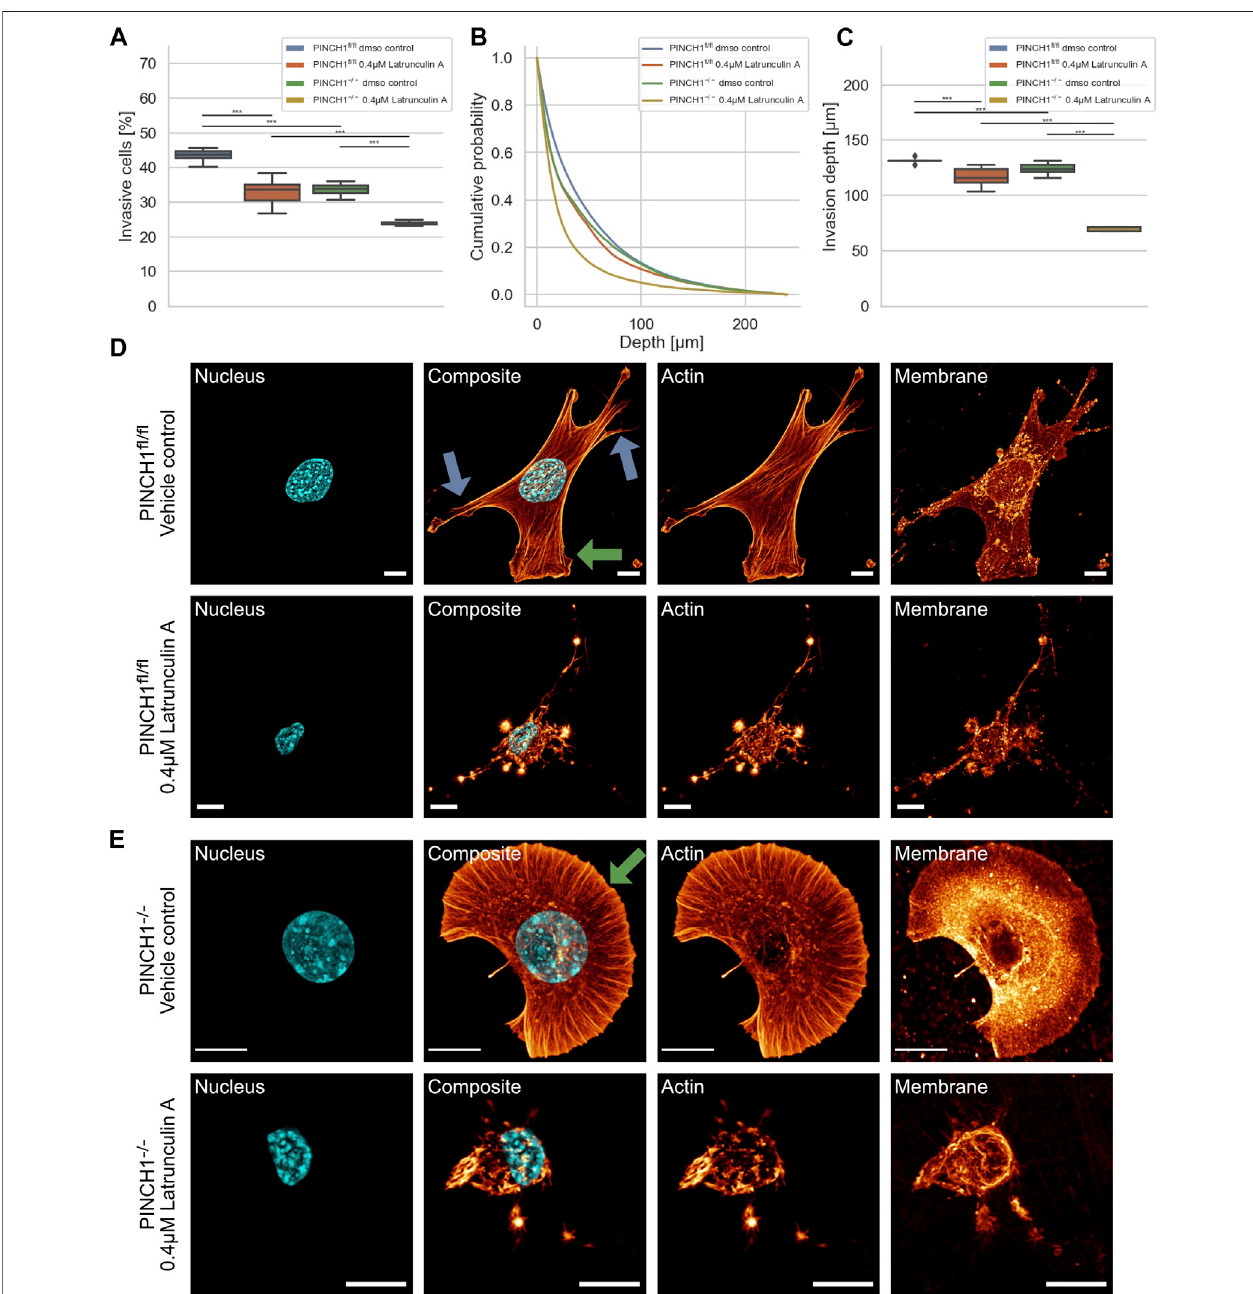
FIGURE 3 | 3D collagen invasion of PINCH1 − / − and PINCH1 fl / fl cells in the presence or absence of Latrunculin A treatment. (A) Average percentage of invasive migrating PINCH1 − / − cells (yellow, n = 982,978 cells with Latrunculin A; green, n = 312,813 buffer-treated control cells) is pronouncedly decreased compared to PINCH1 fl / fl cells (red, n = 307,743 cells with Latrunculin A; blue, n = 1,135,294 buffer-treated control cells) after Latrunculin A. The Latrunculin A-treatment caused a reduction in the percentage of invasive cells compared to their buffer-treated controls. (B) Invasion depth pro fi les of the invasive PINCH1 − / − cells (green, n = 105,835 cells in the absence, yellow, n = 236,225 in presence of Latrunculin A and invasive PINCH1 fl / fl cells (blue, n = 495,742 cells in the absence, red, n = 101,896 in presence of Latrunculin A that migrated in the 3D extracellular matrices after three days of culture at 37 ° C, 95% humidity and 5% CO 2 in the presence and absence of Latrunculin A. (C) The invasion depths of Latrunculin A-treated PINCH1 − / − cells is most pronouncedly impaired compared to Latrunculin A-treated PINCH1 fl / fl cells. Moreover, the average invasion depths of PINCH1 − / − cells (green column) is pronouncedly lower compared to PINCH1 fl / fl cells (blue column) either in the presence or absence of Latrunculin A. (A,C) data are presented as box and whiskers plots (Q2 represent mean values). (D,E) Confocal laser scanning images are presented as maximal projections. Inhibition of actin polymerization by Latrunculin A alters the morphology and the actin cytoskeleton of PINCH1 fl / fl cells (D) and PINCH1 − / − cells (E) . Nuclearshape,compositeofnuclearshape, actincytoskeletonandmembraneshapeofarepresentativePINCH1 fl / fl cell (D) orPINCH1 − /- cell (E) inabsence(upperrow) and presence of Latrunculin A (lower row) is provided. (D,E) Blue arrows indicate lamellipodia, green arrows indicate fi lopodia. All experiments are conducted in quadruple or quintuple. All scale bars are 10 µm. (*** p < 0.001; Kruskal-Wallis test).